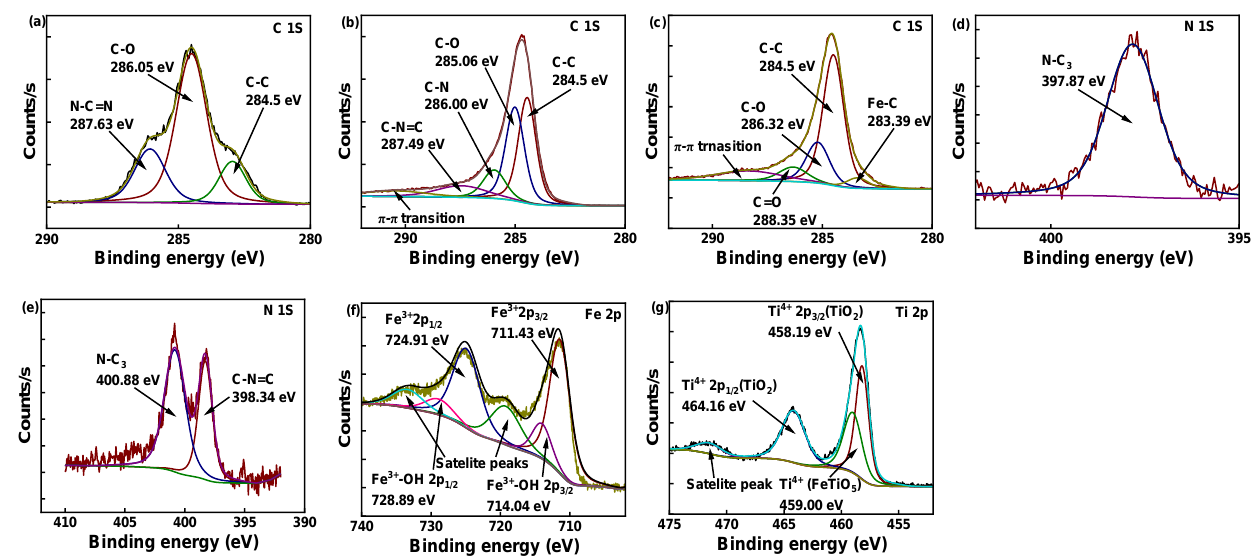
Figure 6. The higher resolution spectrum of ( a ) C 1s of chitosan, ( b ) C 1s of C 800, ( c ) C 1s of CIL (1:2), ( d ) N 1s of chitosan, ( e ) N 1s of C 800, ( f ) Fe 2p of IL and ( g ) Ti 2p of IL.